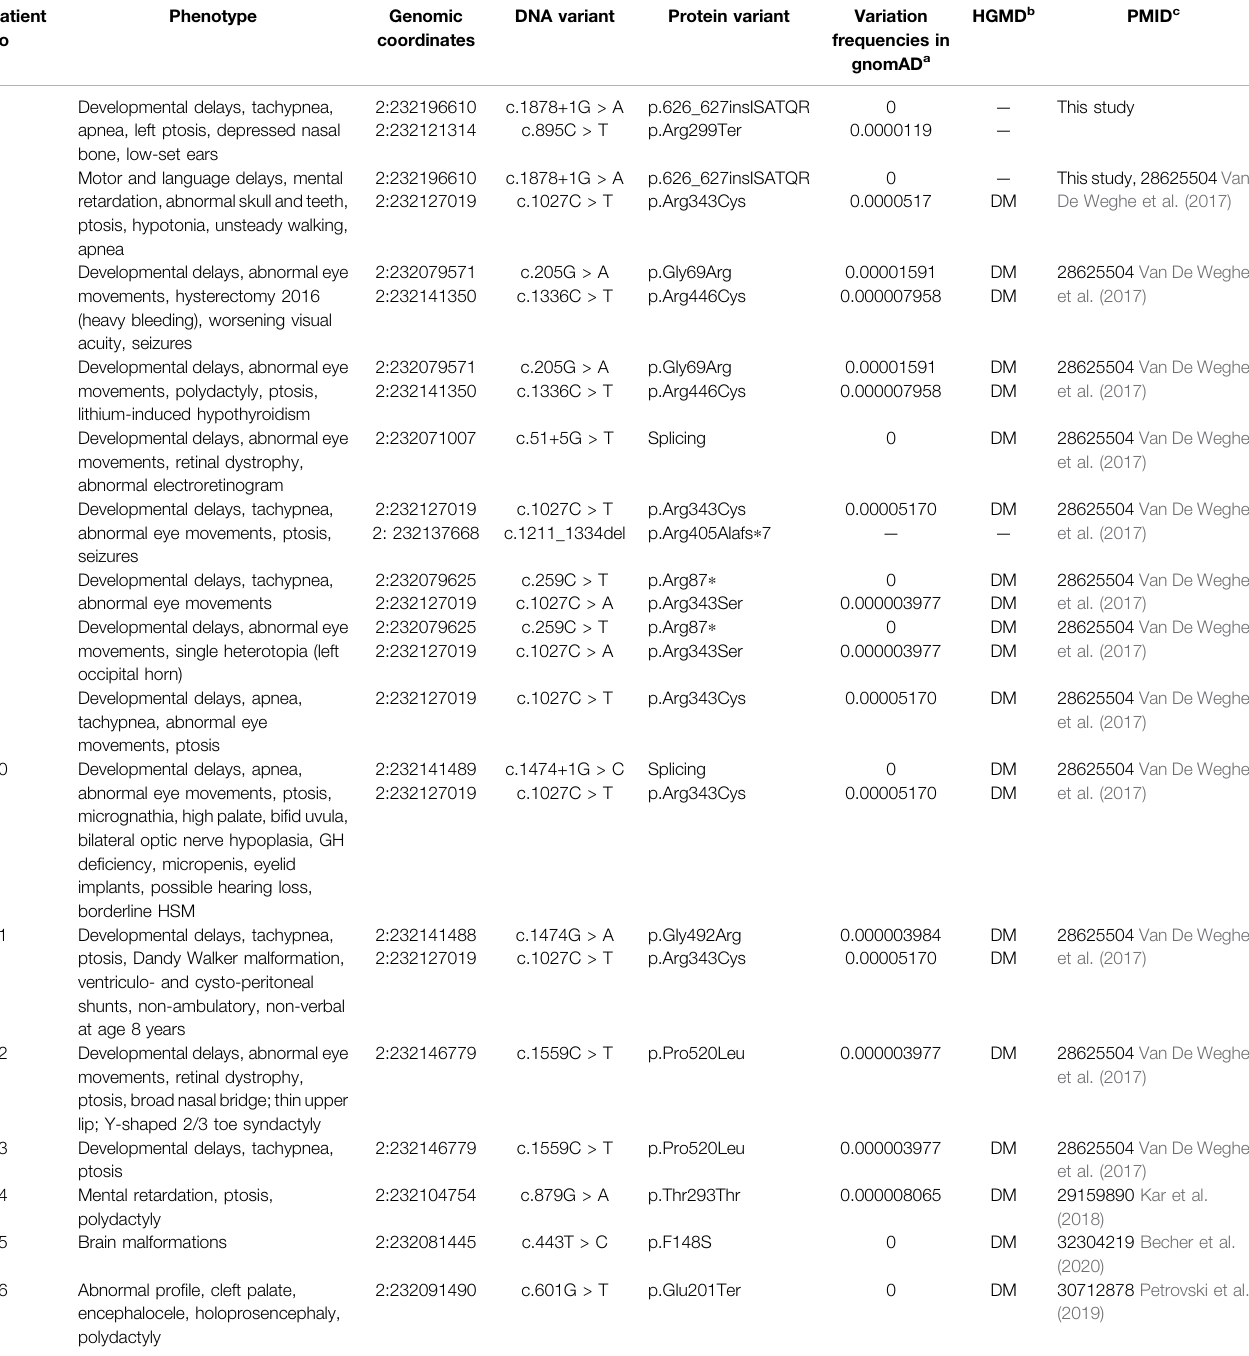
TABLE1| Variantsinthe ARMC9 (NM_025139.6)geneassociatedwiththeJSphenotypeidenti fi edintheliteratureandthisstudy.Theaminoacidlistbeforeischangedtoa stop codon (Ter,